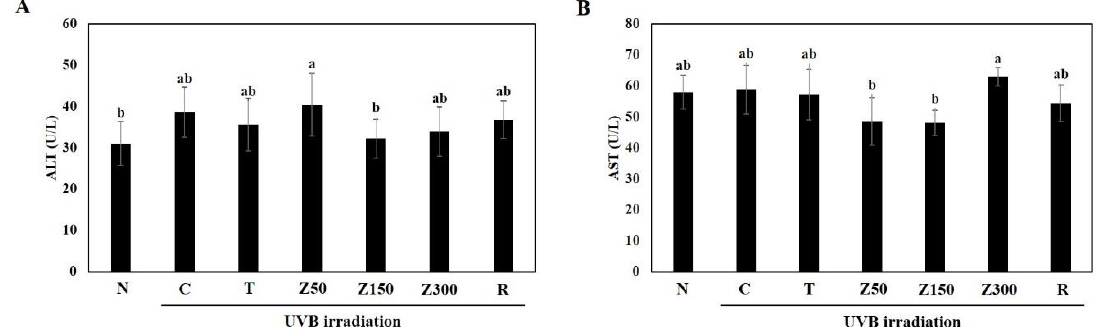
Figure 1. Effects of tricin and ETZL on serum biochemical indicators in UVB-irradiated SKH-1 hairless mice. ( A ) Serum alanine transaminase (ALT) and ( B ) aspartate transaminase (AST) activity in the hairless mice. N, normal control; C, UVB-irradiated control; T, tricin (0.3 mg/kg) oral administration with UVB irradiation; Z50, ETZL (50 mg/kg) oral administration with UVB irradiation; Z150, ETZL (150 mg/kg) oral administration with UVB irradiation; Z300, ETZL (300 mg/kg) oral administration with UVB irradiation; R, UVB irradiation with dermal application of 0.05% retinoic acid. Values are expressed as mean ± SD of nine mice. Different letters show a significant difference at p < 0.05 as determined by Duncan’s multiple range test.